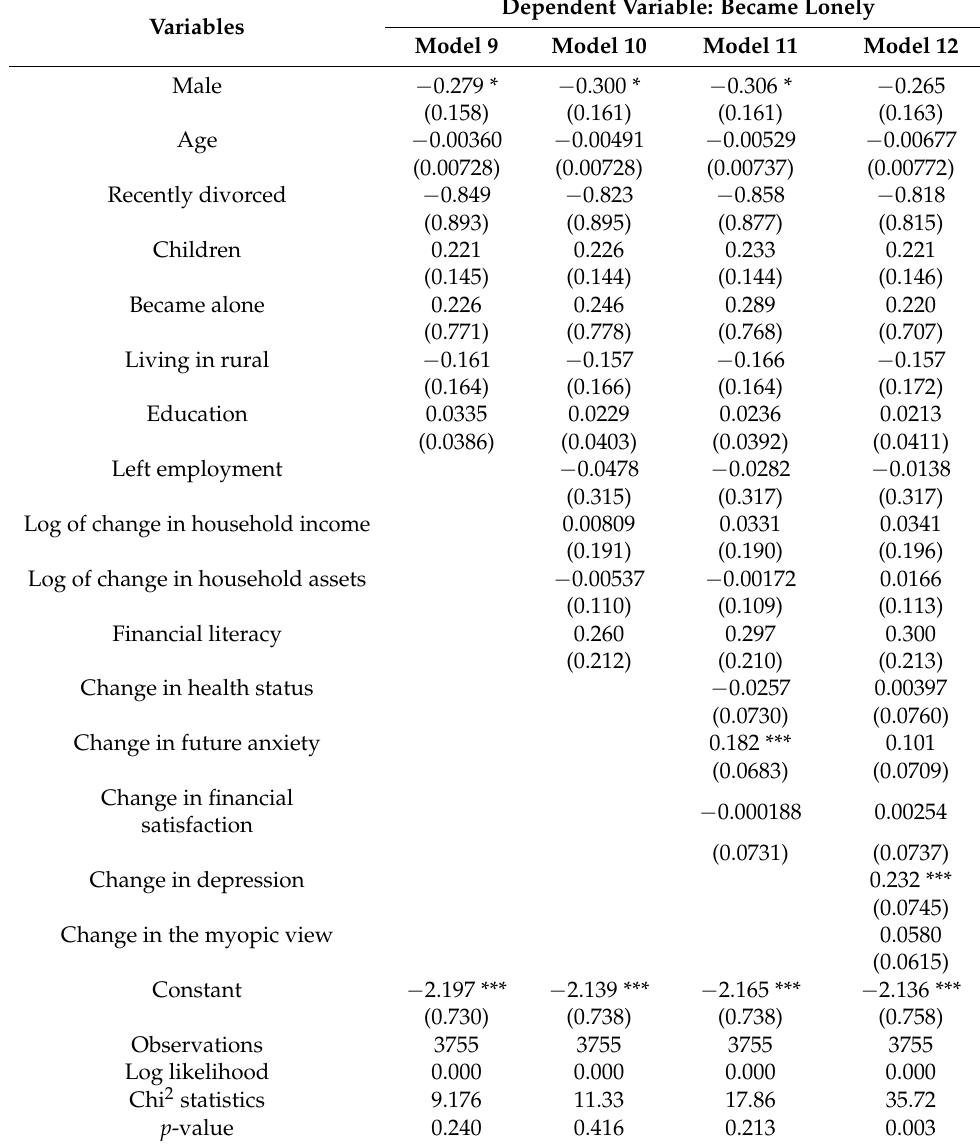
Table 9. Logit regression results of becoming lonely in 2021 (full sample